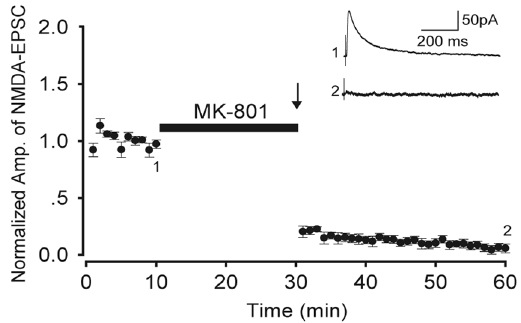
Figure 1. Amplitude of NMDA-EPSCs before and after blocking S-NMDARs. The arrow represents the stimulation time point. Inset: sample traces of NMDA-EPSC at time points 1 and 2, as marked. Data are from nine slices of five